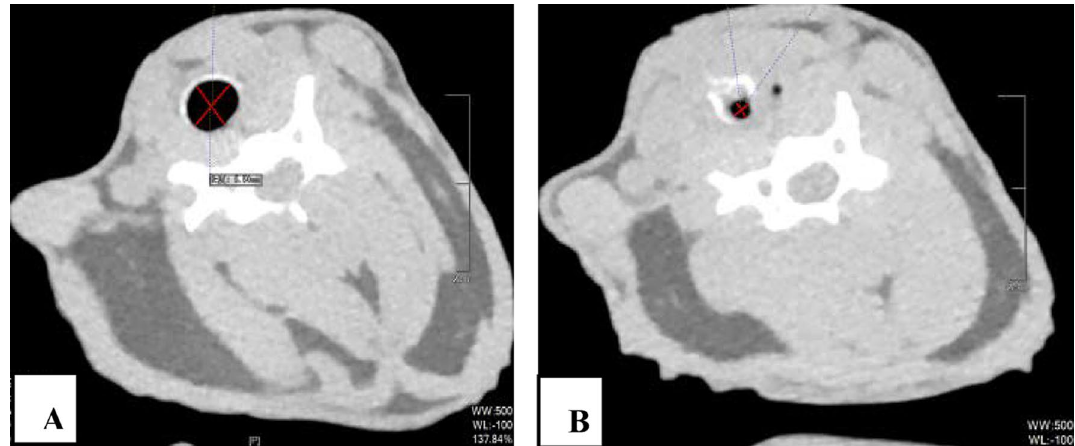
Figure 4. CT scans of rabbits with tracheal stenosis. The CT diagram of the internal tracheal diameter measured by the same experimental rabbit fat window (window width 500 Hu, window level −100 Hu): ( A ) normal tracheal lumen, ( B ) narrow tracheal lumen. CT computed